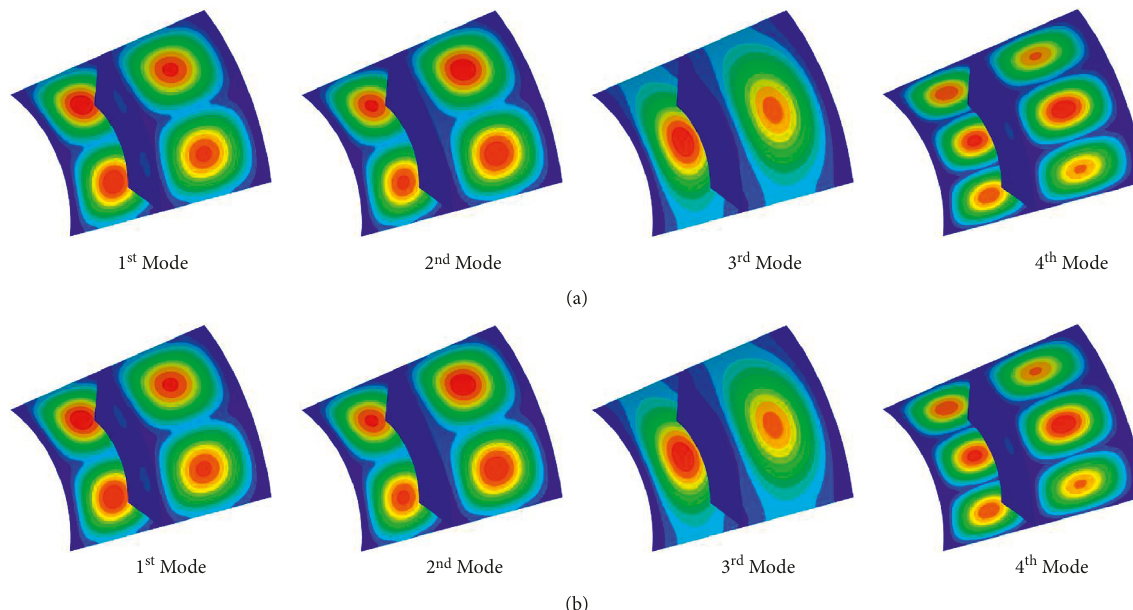
Figure 4: Mode shapes of functionally graded open cylindrical shell with a circumferential bulkhead and CSCS boundary condition ( h � 0.05 m): (a) present and (b)